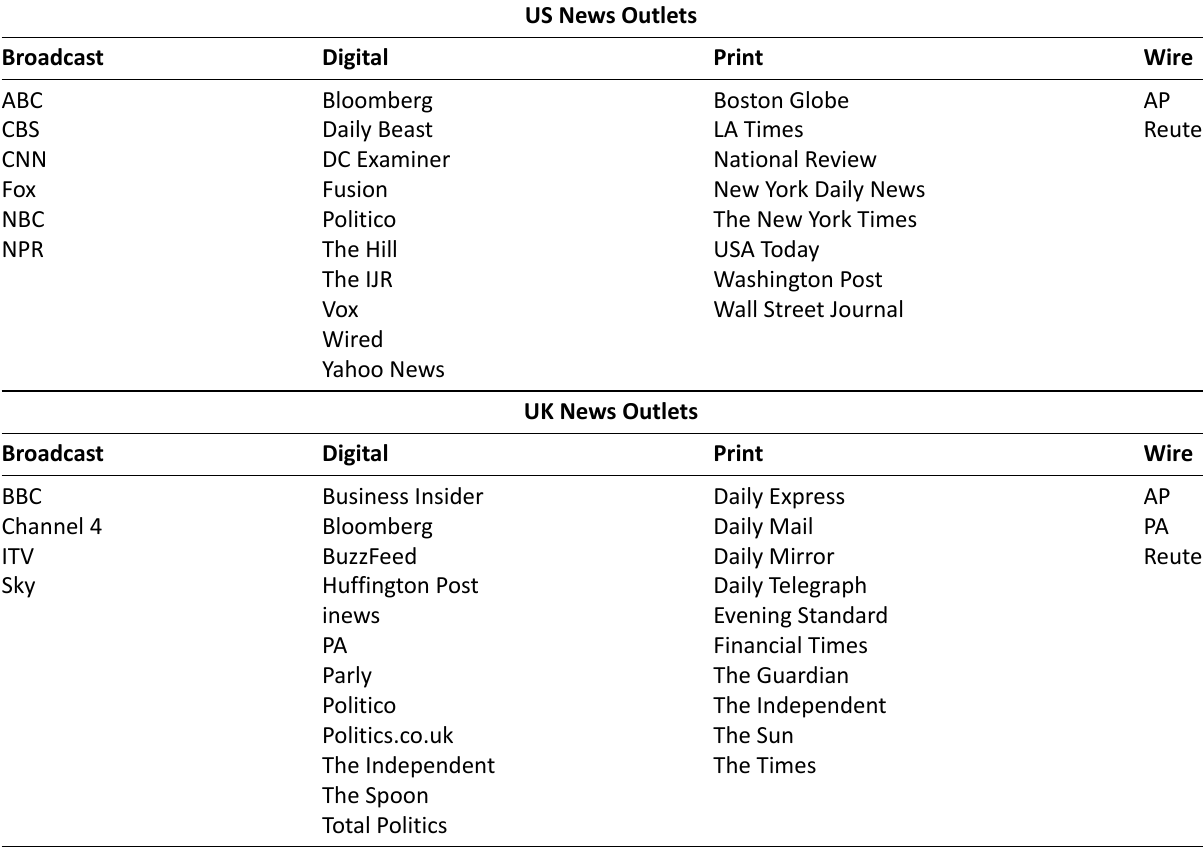
Table 1. US and UK news outlets in